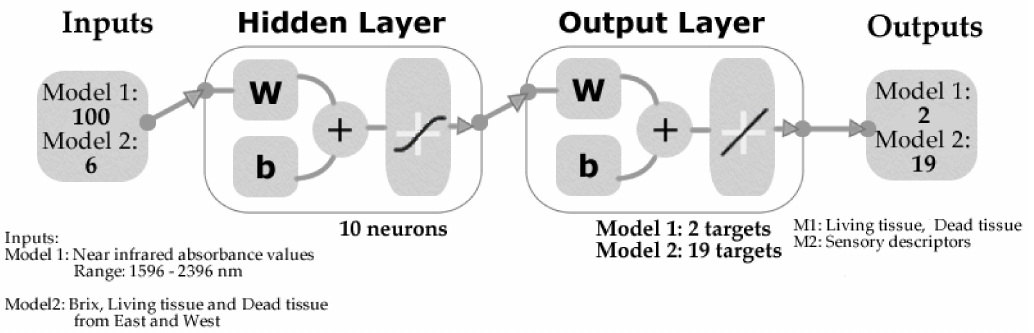
Figure 2. Diagram of the artificial neural network models showing the inputs, neurons, and outputs of each model. Detailed sensory descriptors may be found in Table 1. Abbreviations: W = weights, b = bias.